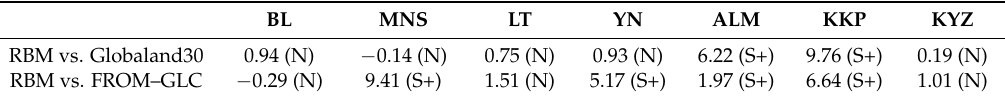
Table 6. McNemar’s test result of RBM results and the two existing cropland maps (Z value and significant